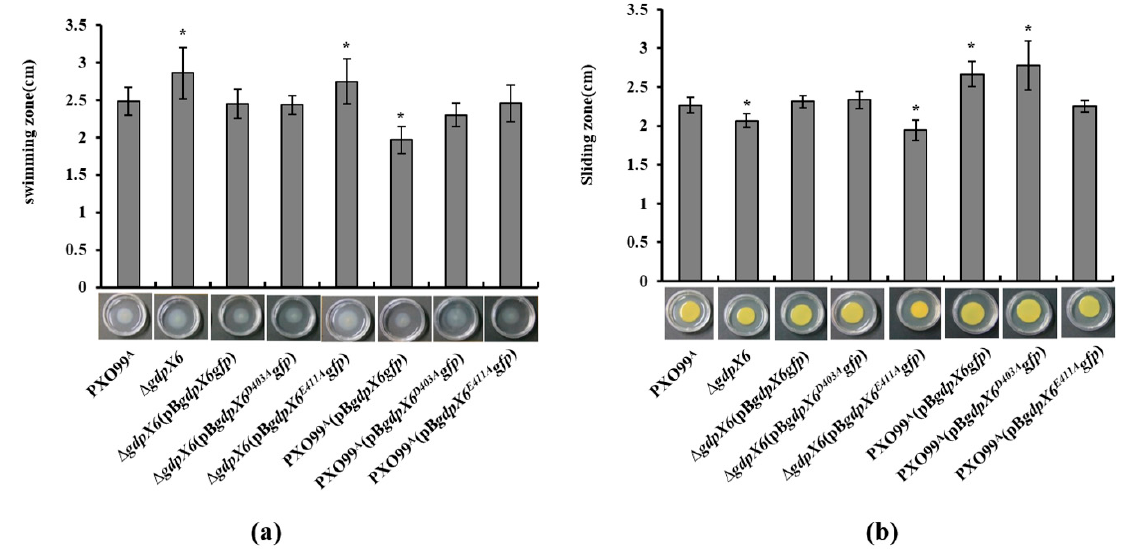
Figure 5. GdpX6 regulated swimming motility and sliding motility of Xoo . Xoo strains were inoculated on ( a ) semi-solid plates containing 0.25% agar for testing the swimming motility and ( b ) Super Broth (SB) plates containing 0.6% agar for testing the sliding motility at 28 ◦ C for 4 days. The values are the means ± standard deviations from three replicates of three independent experiments. * indicates p < 0.05 as determined by t ‐ test .